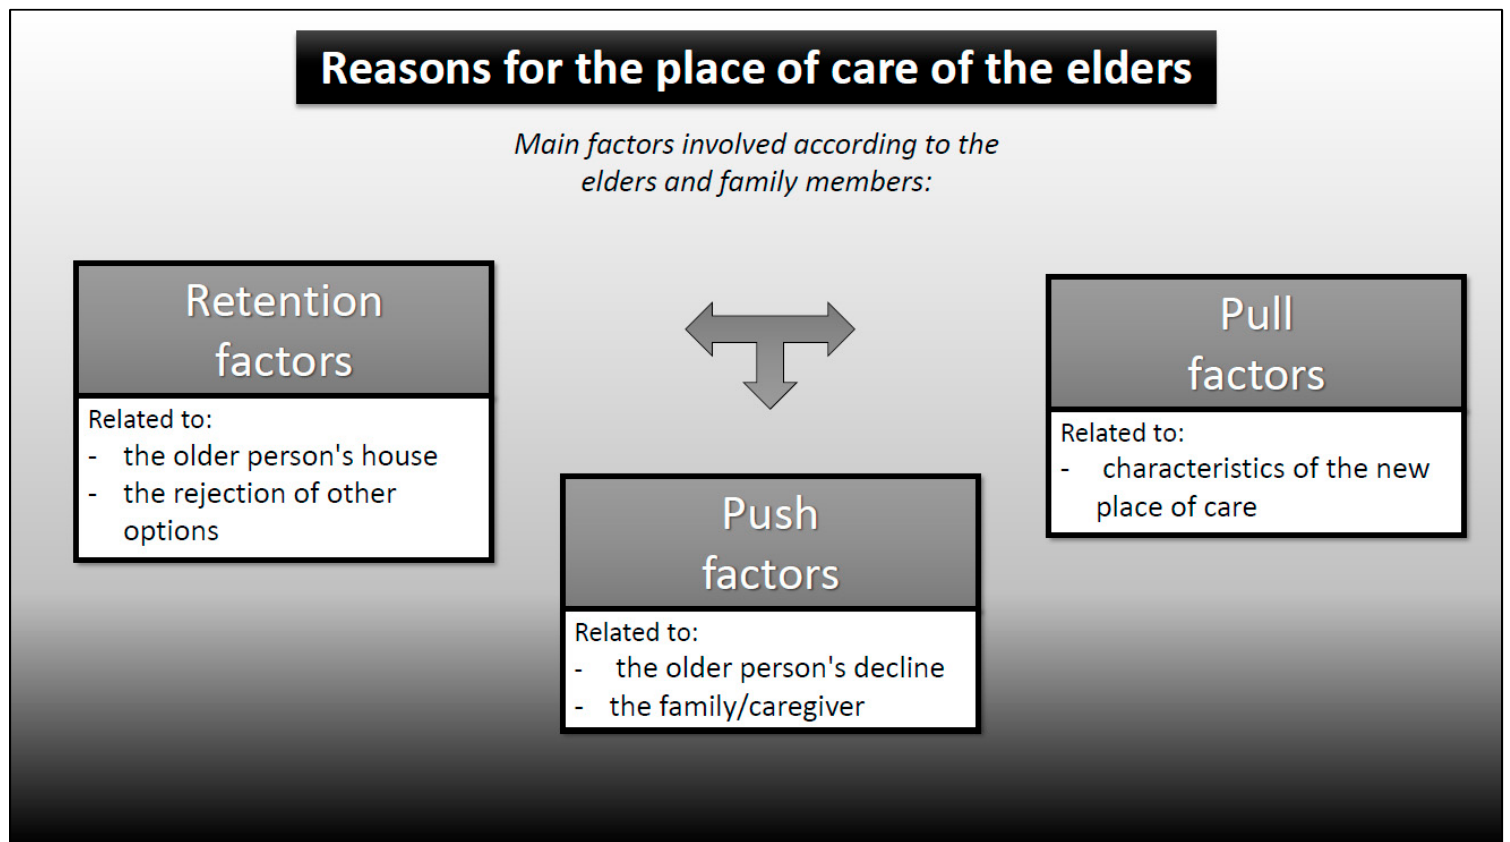
Figure 2. Main factors involved according to the elders and family members. Source: Own elaboration based on the information obtained from the studies included in this systematic review (more detailed information on these factors can be found in the Supplementary Materials: Table S2: Main factors: elders and family members).